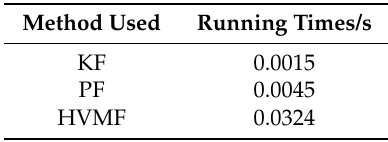
Table 3. Running times of each